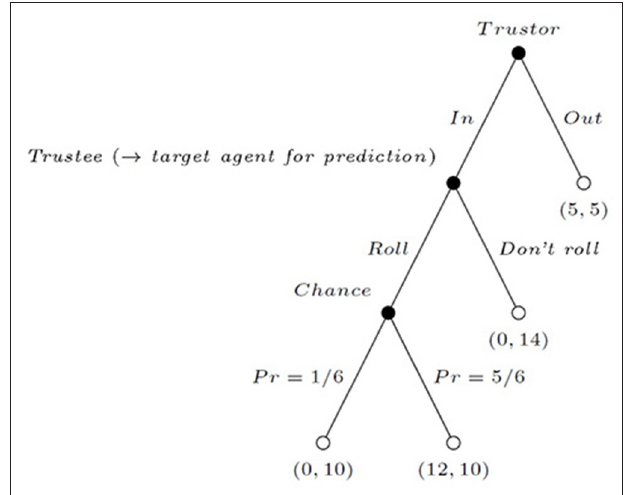
FIGURE 1 | Experimental hidden action